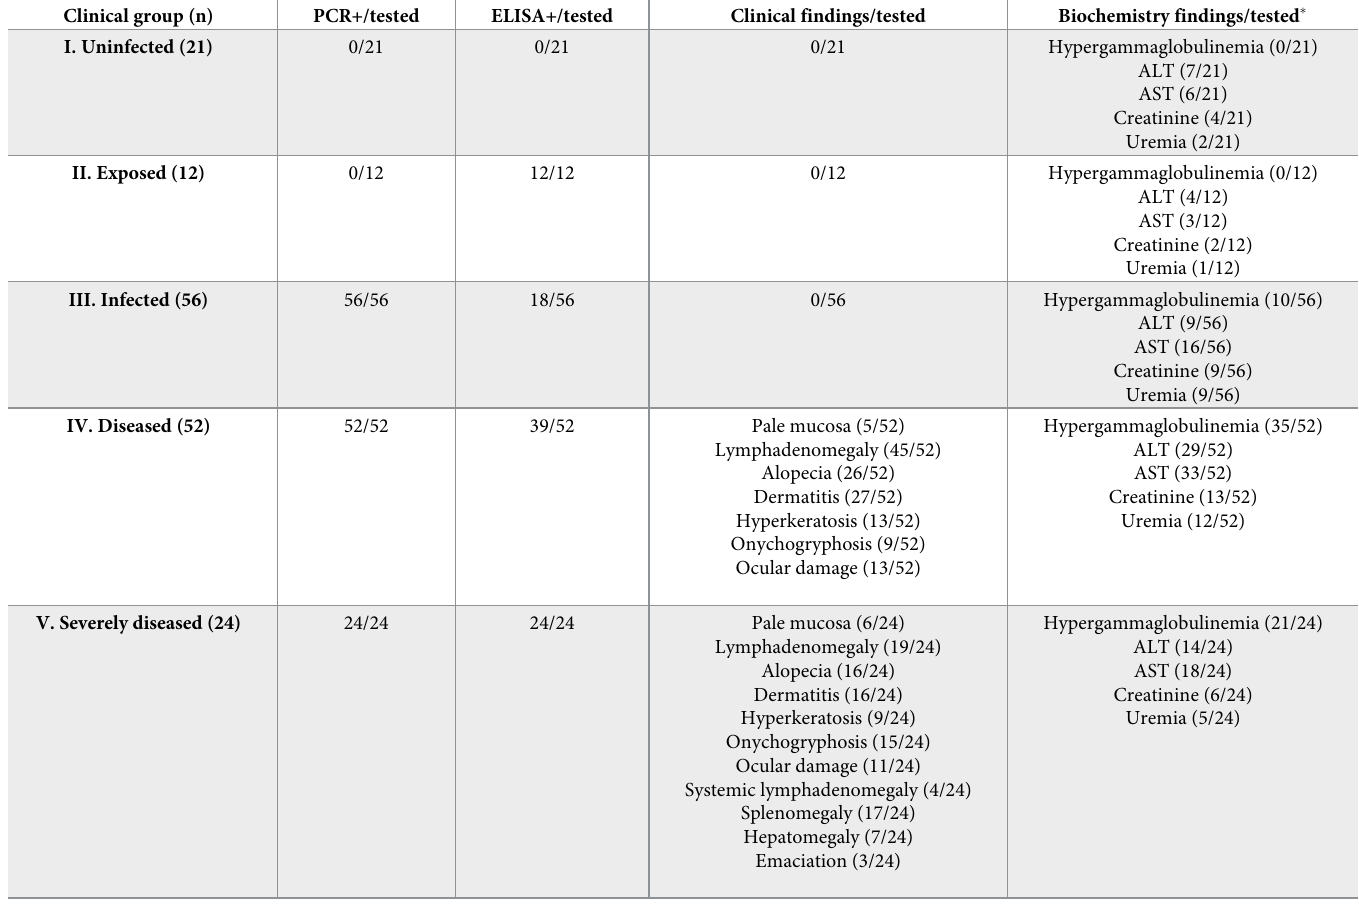
Table 1. Proportion of positive results in the parasitological and serological diagnosis and clinical and biochemical findings of each clinical group. Clinical group